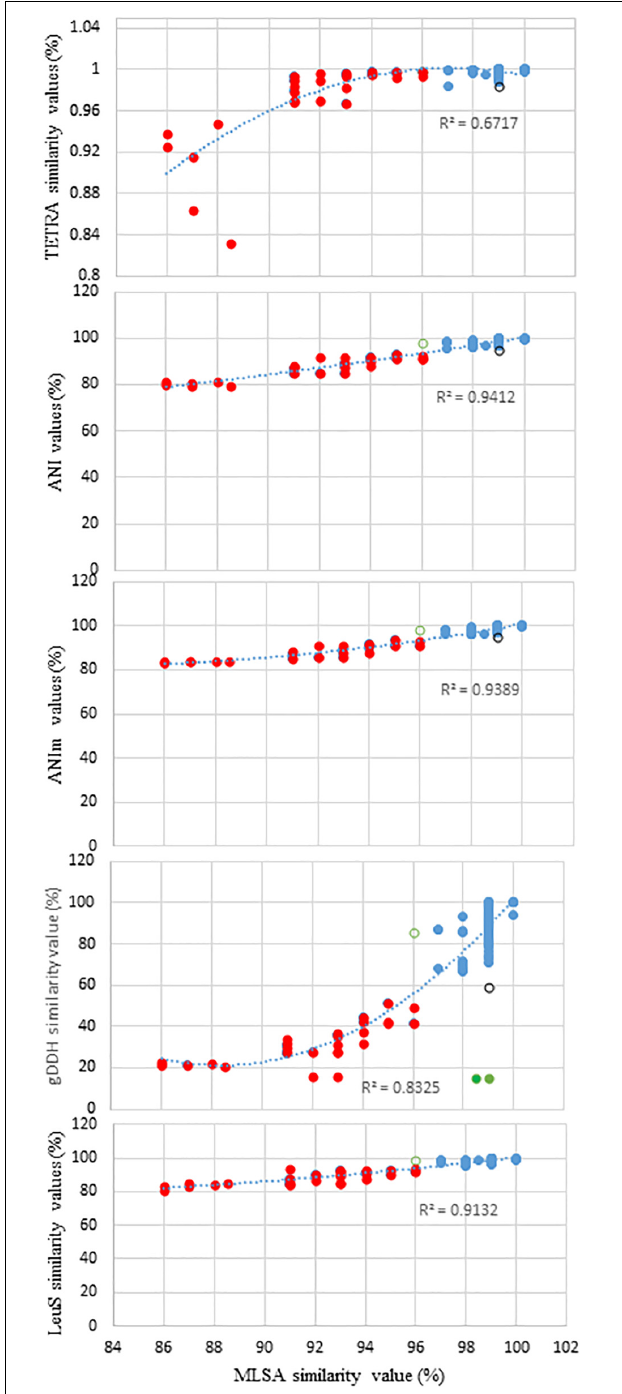
FIGURE 1 | Distribution of the average nucleotide identities (ANI), MuMmer-based average nucleotide identity (ANIm), tetranucleotide usage pattern (TETRA), leu S, and genome-based DNA-DNA hybridization (gDDH) data of all the genome sequences plotted against MLSA with a species delimitation cut-off value of 97%. Blue dots, accurately identified to the species-level: gDDH > 70%; ANI or ANIm > 96%; and TETRA > 0.998; red dots, indices lower than the respective cut-off threshold values (misidentified strains